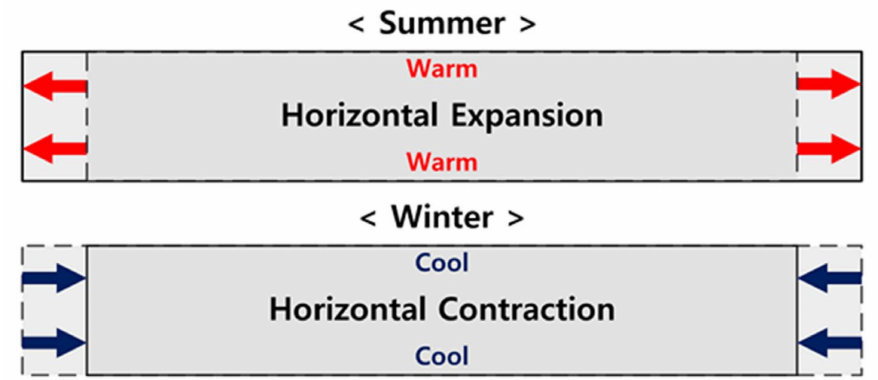
Figure 17. Long-term behavior of concrete slab estimated by the real strain.